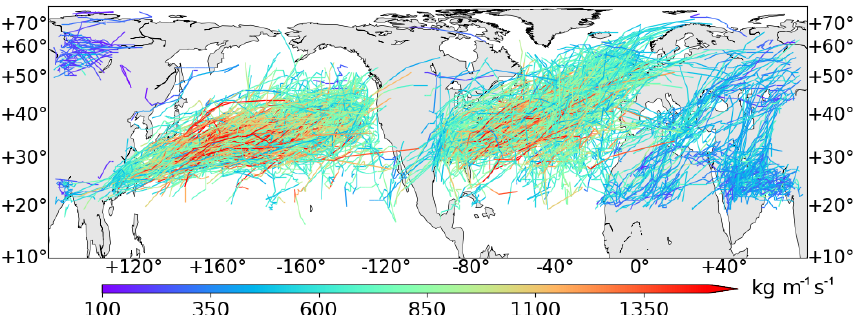
Figure 10. Movement of Northern Hemisphere AR tracks as indicated by the geometrical centroids during the November–April seasons of November 2004 to April 2010. Color represents the maximum IVT within the AR region.